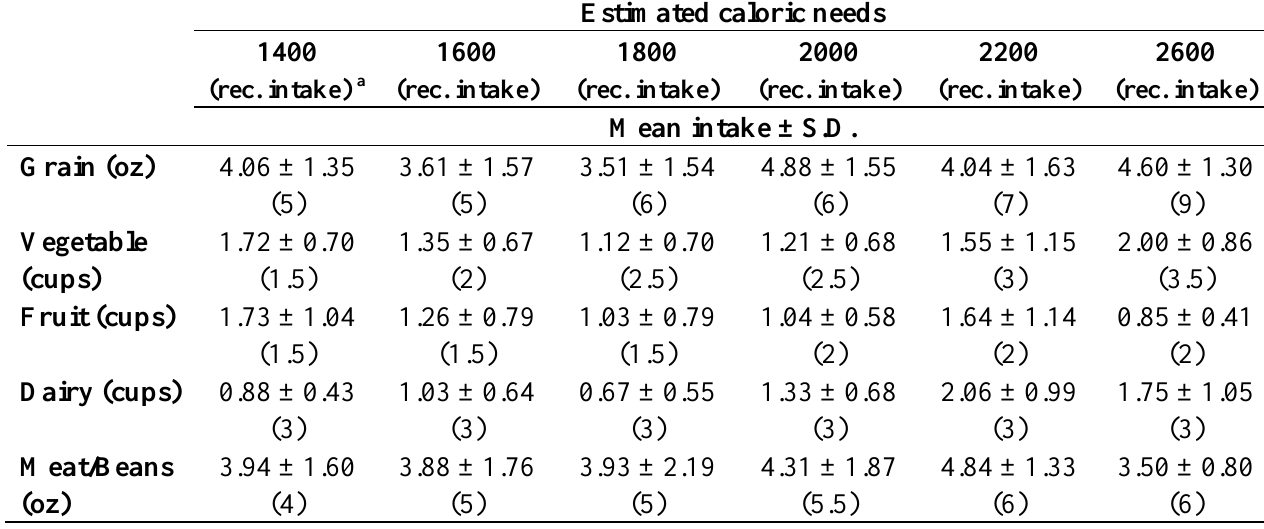
Table 3. Mean food consumption of each food group based on estimated caloric